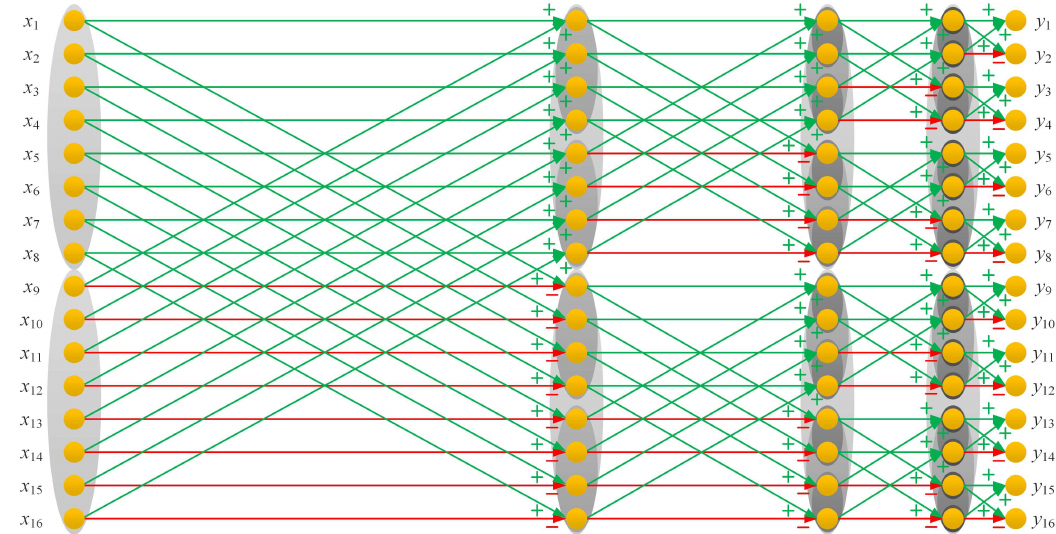
Figure 3. Simplified mathematical model (graph) for the Hadamard matrix multiplication calculation, taking H 16 for an